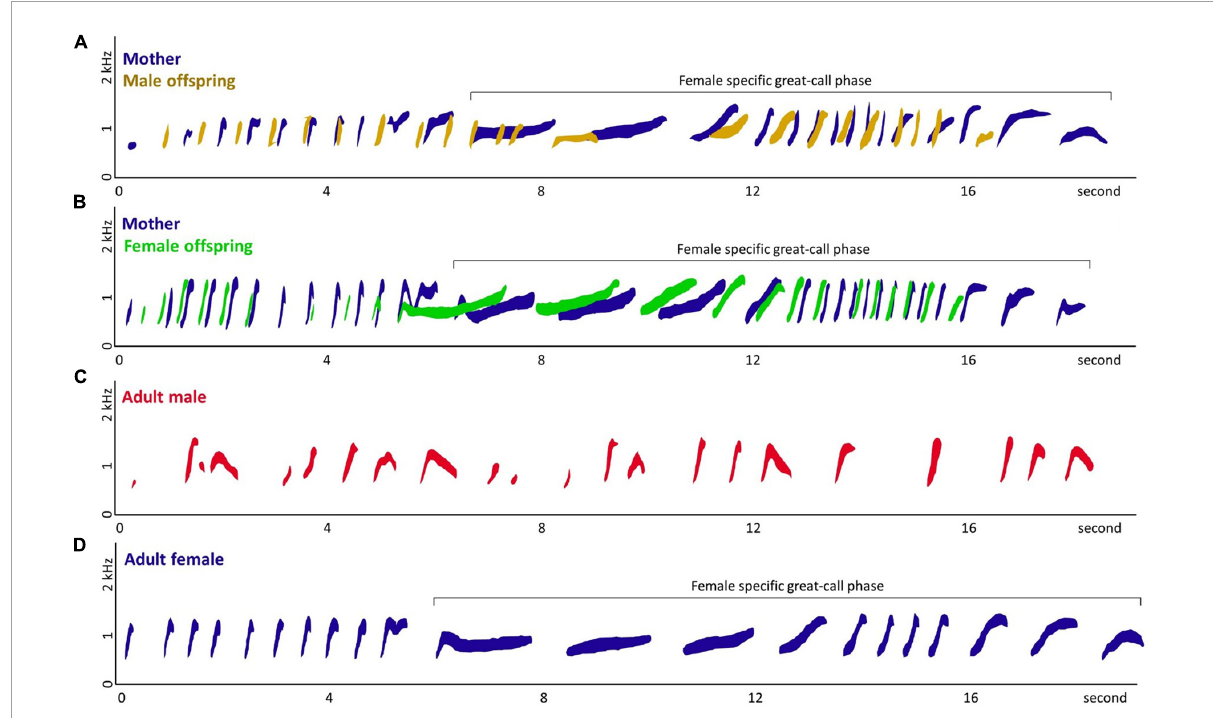
FIGURE1 Spectrograms of (A) co-singing between mother and male offspring, (B) co-singing between mother and female offspring, (C) adult male solo, and (D) adult female solo of Hylobates moloch . Panel (A) was recorded from gibbon group S, Surti (mother), and Salwa (male offspring; subadult) in September 2019. Panel (B) was recorded from gibbon group A, Ayu (mother), and Asri (female offspring; adolescent) in September 2009. Panel (C) was recorded from the Javan Gibbon Center, Gunung Gede-Pangrango, Indonesia, in September 2009, due to the difficulty of recording rare adult male solos in the wild. Panel (D) was recorded from the gibbon group B, Bu Keti (adult female) in April 2011. Except (C) adult male solo, all were recorded from the focal gibbon groups in the study area, Gunung Halimun-Salak National Park, Indonesia. The spectrograms were extracted from the recordings using Raven Lite (Version 2.0.3; Yang, 2022) and we manually traced the spectrograms to specify the